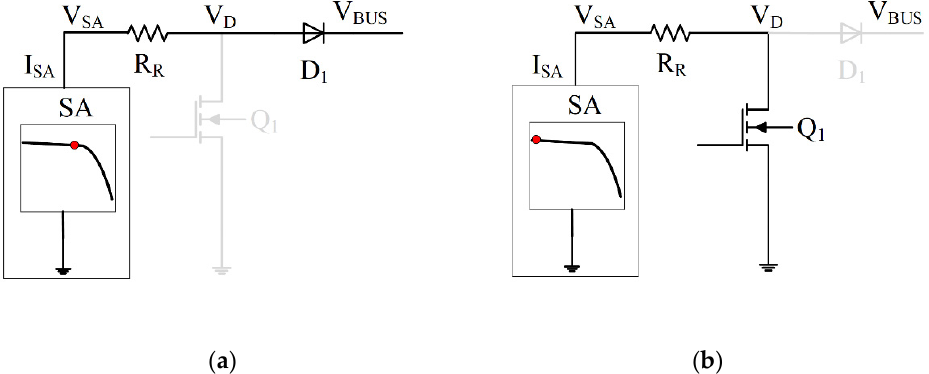
Figure 13. Shunt regulator operation modes. ( a ) Bus feeding mode; ( b ) Shunt mode. As shown in Figure 13b, when the SR is in shunt mode, the SA operates at the short circuit working point, and the steady state is as shown in Equation (15). When an arc fault occurs, the SA working point shifts toward the right. However, limited by the contact resistance, during the arcing period, the SA always operates in the constant current region, which makes it difficult to cut the arc off in shunt